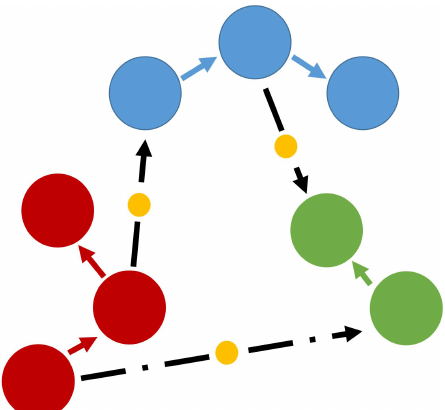
Figure 6. Illustration of submap-based back-end, three submaps are shown in the figure (red, green and blue), and they are connected by constraints (arrows) between/within submaps, where the yellow points are the switchable factors for robustness loop-closure detection.